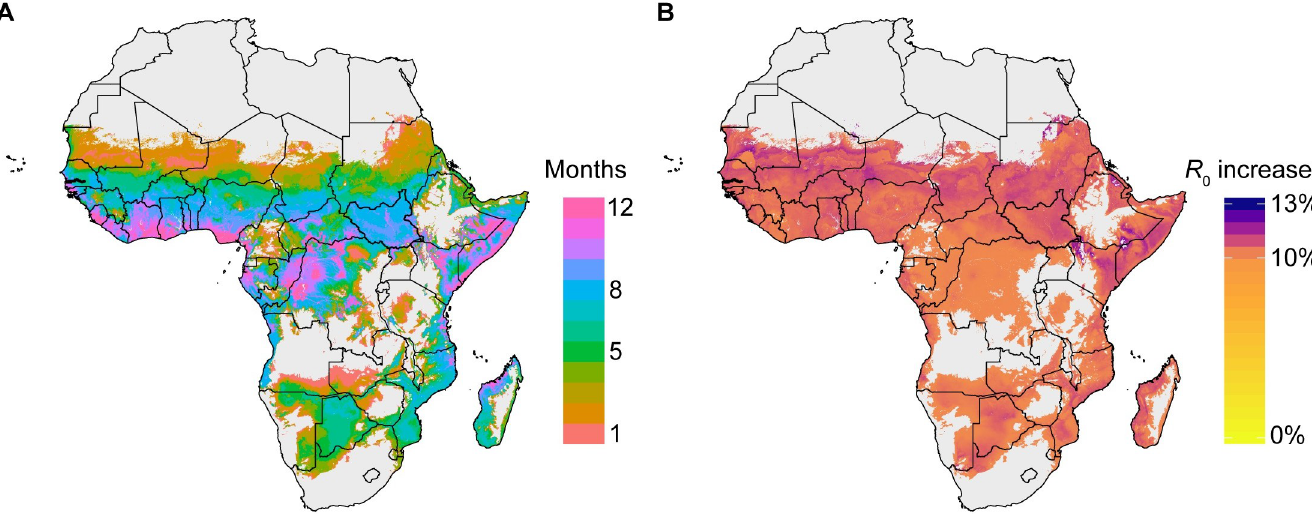
Fig 4. Relative R 0 values across sub-Saharan Africa show increase in malaria transmission potential. (A) Regions of sub-Saharan Africa with 1 to 12 months of average temperature in 27 ± 2˚C. Our modeling analysis was restricted to locations and months of the year during which the average temperature was in this range, in order to align with our laboratory conditions. Areas in gray depict regions where there are 0 months with average temperature in that range, or where the predicted probability of An . gambiae complex is less than 5%. (B) The percent increase of R b using revised estimates of EIP 50 (derived from two blood feeds) to R 0 using the 0 standard estimates of EIP 50 (derived from a single blood feed). Models using a standard EIP parameter may underestimate R 0 by an average of least 10.1%. In these regions, the average change during the months within the relevant temperature range is 10.5% (range: 10.1%–12.1%).